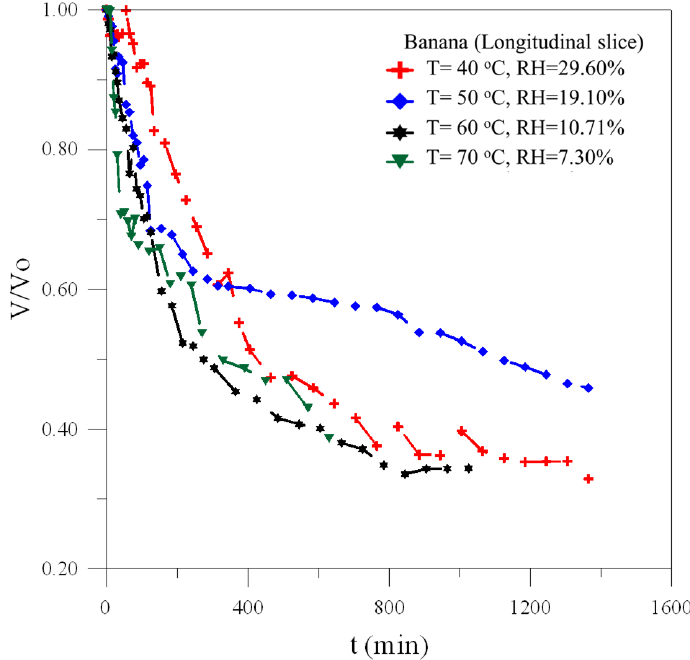
Figure 3. Dimensionless volume of the longitudinal sliced banana as a function of the drying time.